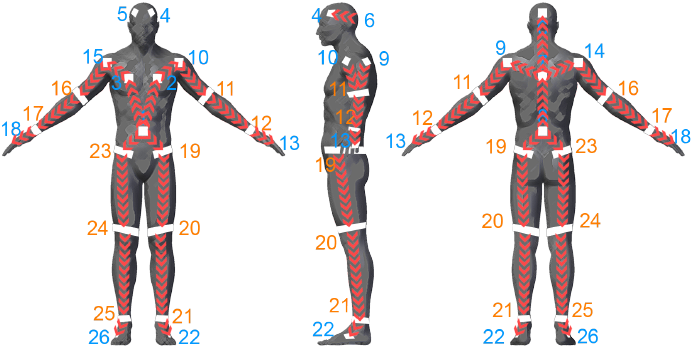
Figure 11. The red arrows illustrate the directional associations between the reflectors to adapt the Part Affinity Fields, as proposed in [14]. The orange and blue colored labels indicate the reflective straps and patches, respectively.